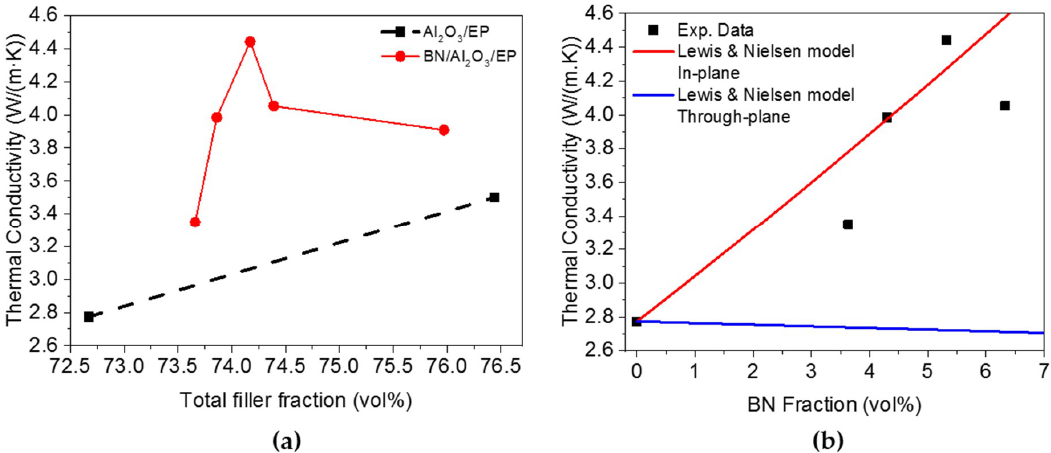
Figure 7. Thermal conductivity of the composite materials versus total filler fraction ( a ), and comparison of experimental data and the model predictions as a function of BN fraction ( b ).